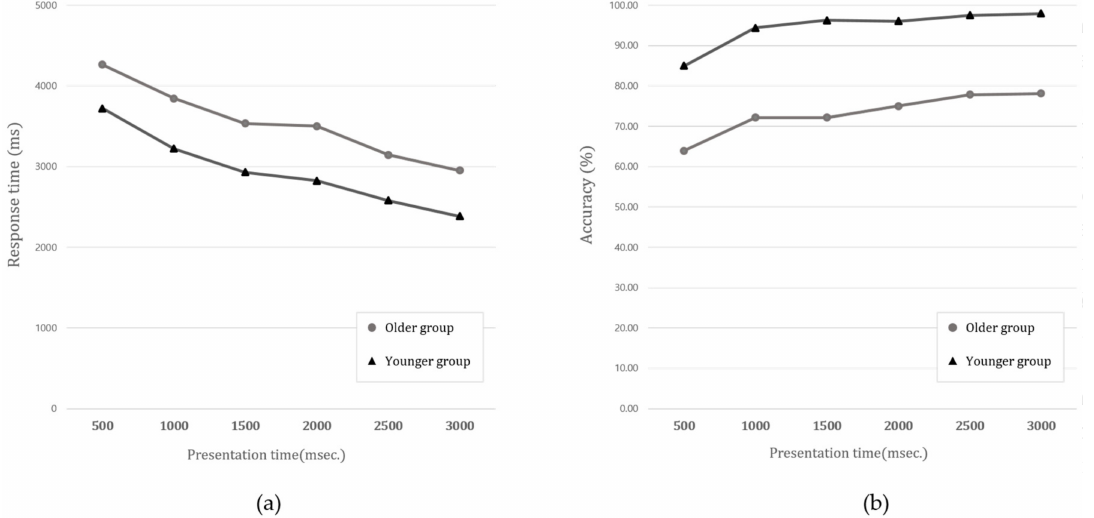
Figure 4. Changes in ( a ) response time and ( b ) accuracy across presentation time. Table 1. Descriptive statistics of response time and accuracy across presentation